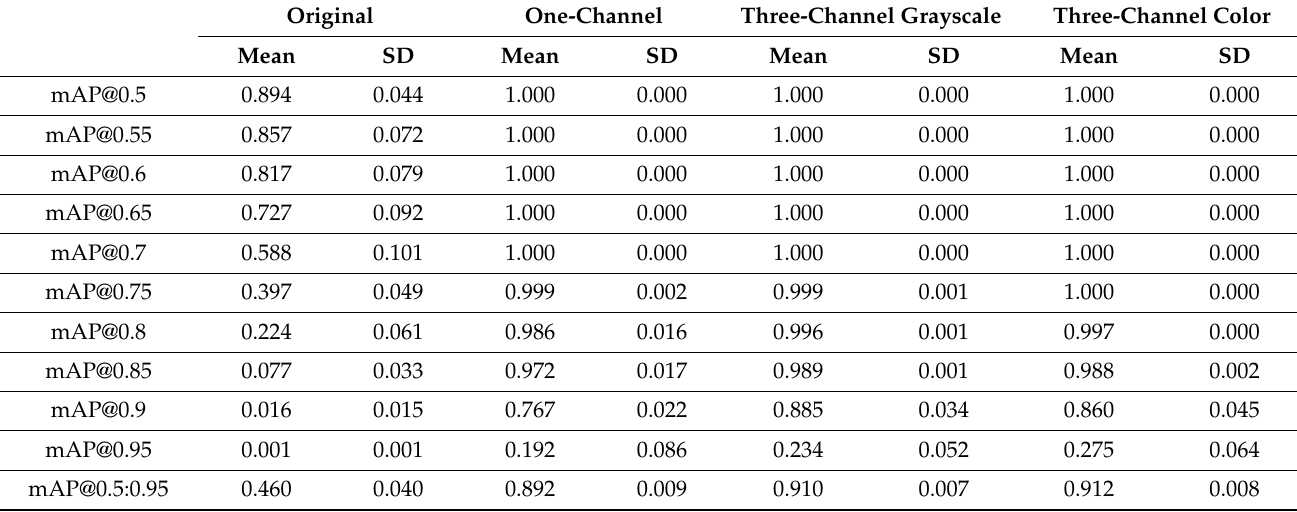
Table 11. YOLOv4 object detection validation results with the original dataset.